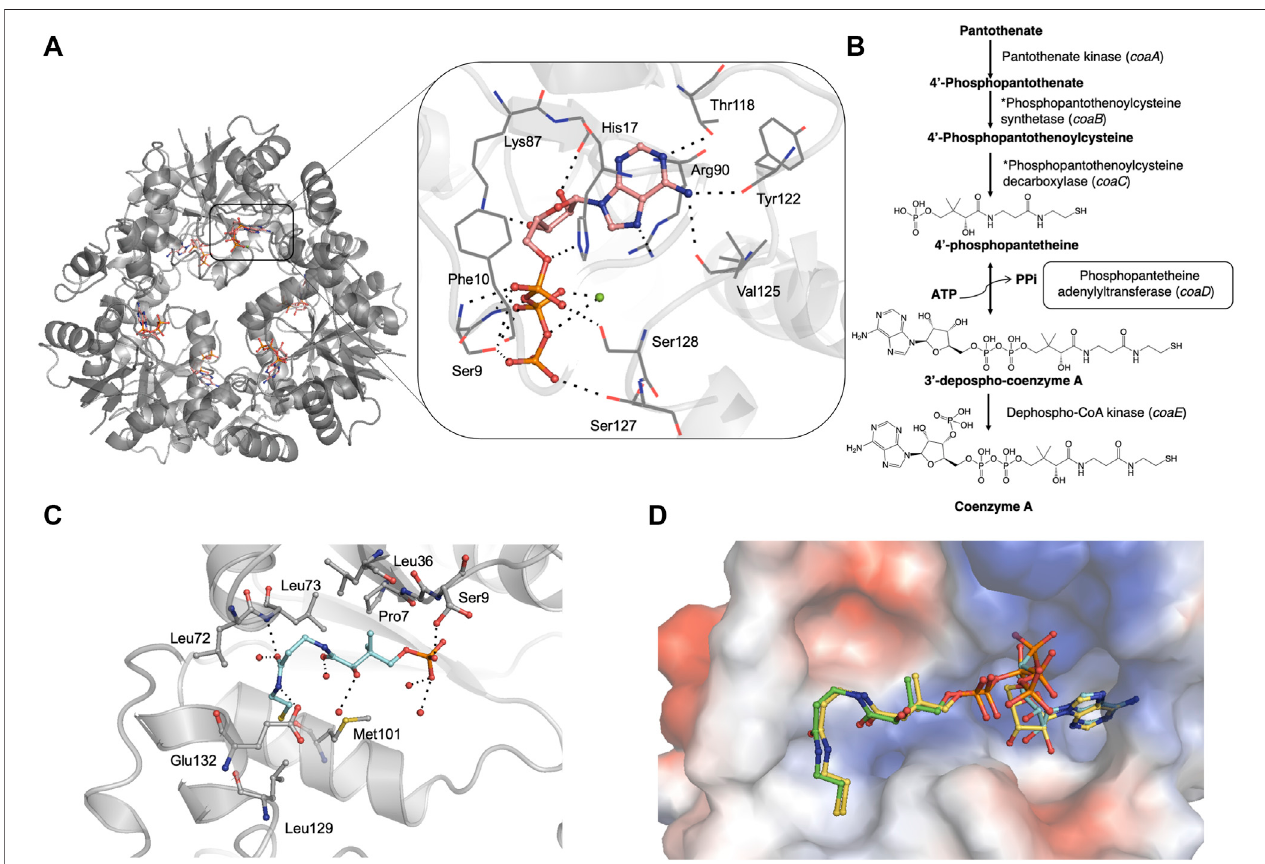
FIGURE 1 | (A) Crystal structure of M. abscessus PPAT hexamer (grey) in complex with ATP (PDB code 7YWM). The detailed interaction map is also shown with ATP in salmon stick model and interacting residues in grey line representation. Polar hydrogen bond contacts are shown in black dotted lines and active site Mg 2+ as green sphere. (B) Biosynthetic pathway of coenzyme A in bacteria. The step catalyzed by PPAT enzyme is highlighted in black box. Corresponding E. coli gene names are given in brackets. *These two steps are catalyzed by a single polypeptide in bacteria. (C) Mab PPAT in complex with 4 ′ -phosphopantetheine (PhP) (PDB code 7YY0) showing interacting residues in grey and PhP in blue stick model. (D) Crystal structure of M. abscessus PPAT in ternary complex with substrates, 4 ′ - phosphopantetheine (PhP) and non-hydrolysable ATP analogue AMPCPP, solved at 1.62 Å (PDB code 7YY1). PhP is shown in green, AMPCPP in blue stick